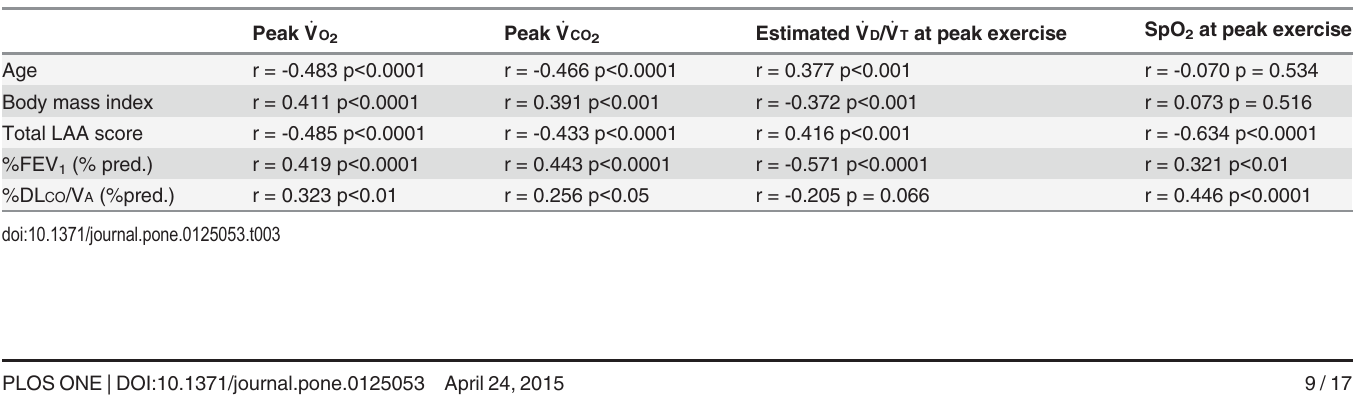
Table 3. Correlation coefficients between cardiopulmonary exercise testing data and other clinical parameters at study